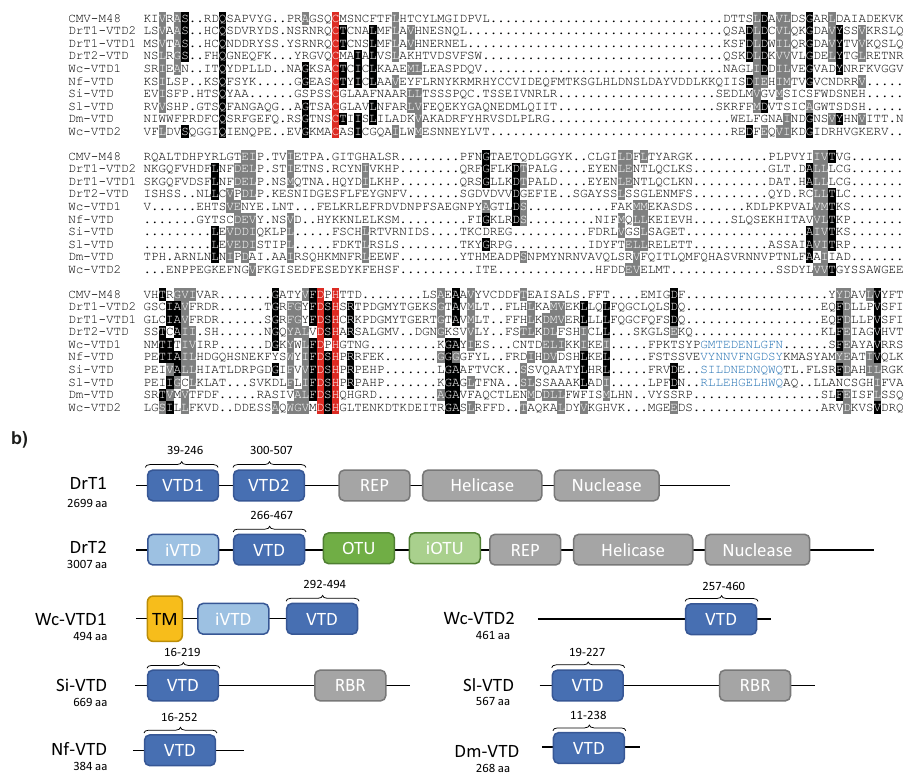
b Domain architecture of the proteins analyzed in this work. Active and inactive VTD domains are shown in blue, other DUB-domains in green, transmembrane- regionsinorangeandotherdomaintypesingrey.ThepositionoftheVDTdomains as aligned in part a) of the fi gure are indicated by